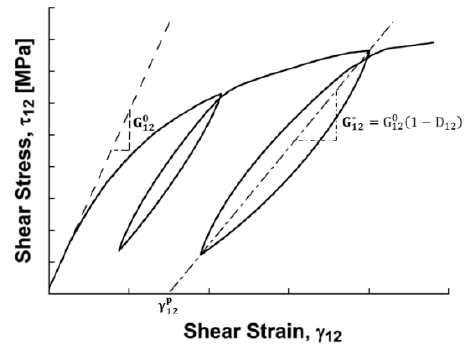
Figure 6. Definition of initial and damaged shear modulus and permanent strain.